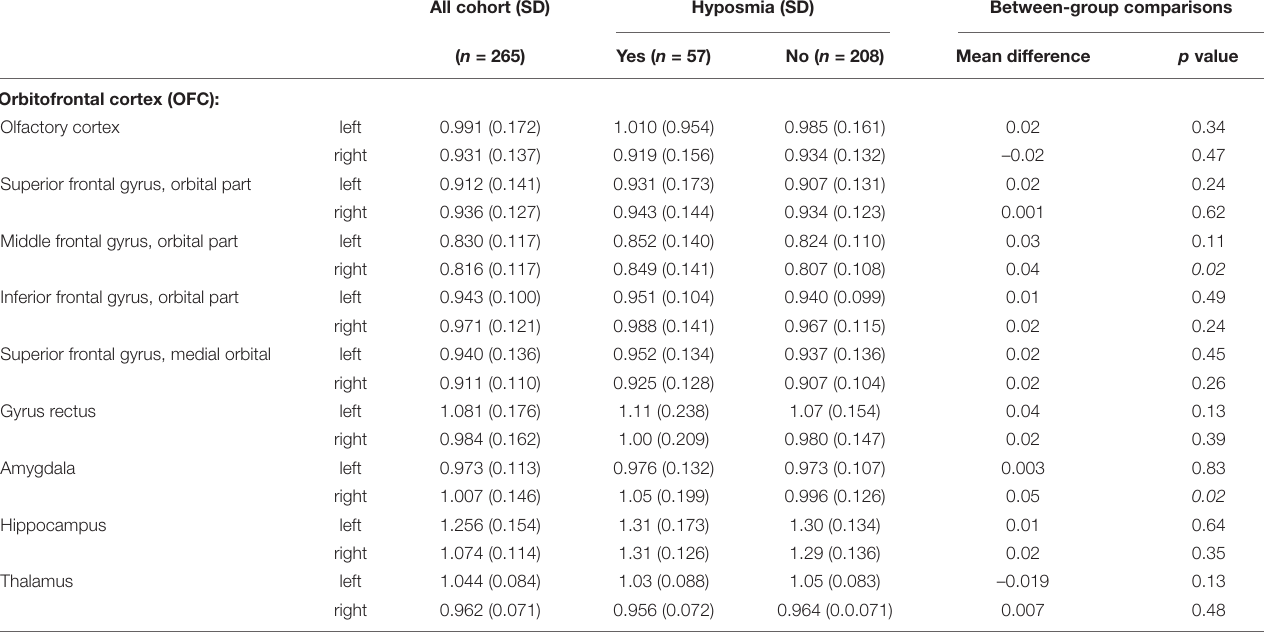
TABLE 2 | Bivariate associations of hyposmia in 1998–99 with mean diffusivity of gray matter in 2006–08 in regions of interest. All cohort